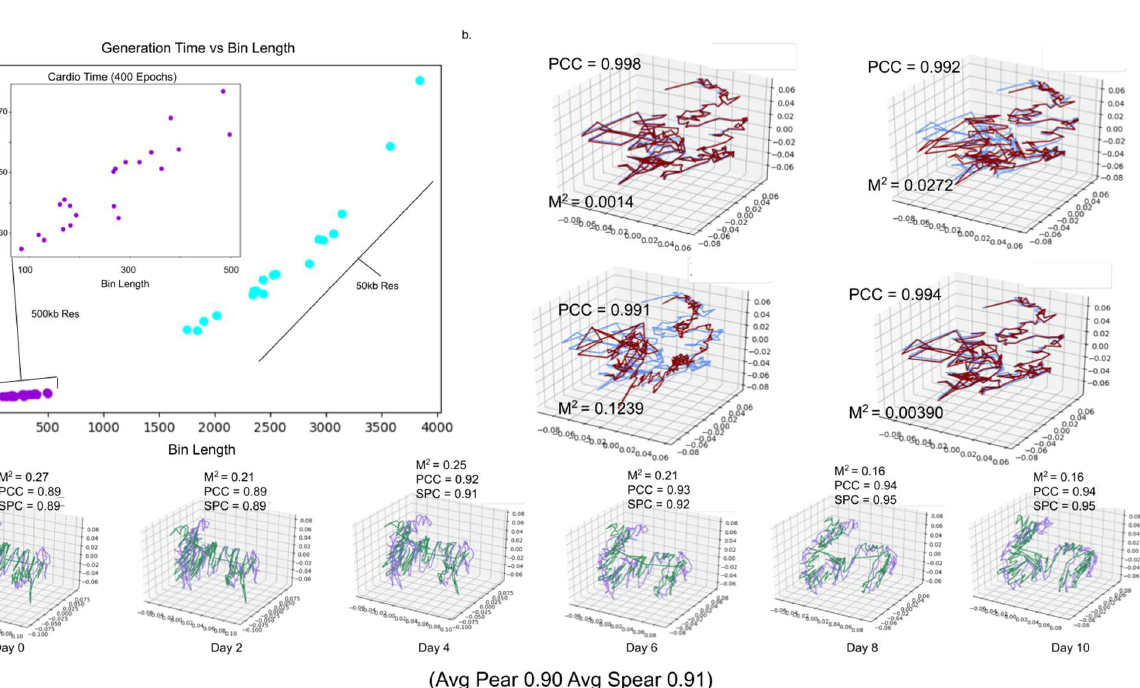
Figure 6. Evaluation of run times and computational stability. ( a ) Scatter plot of chromosome bin lengths and time to completion using 400 epoch (purple) 500 kb resolution chromosome and (blue) 50 kb resolution chromosomes. ( b ) 3D plot of predicted cardiomyocyte chromosome 10 on day 5 with varying granularity values. Spearman correlation Mean Squared distance compares (blue) granularity 15 structure to higher granularity structures (red). ( c ) 3D plots comparing (purple) 50 kb resolution chromosome 1 to (green) 500 kb resolution iPSC chromosome 1 on each day in time series.